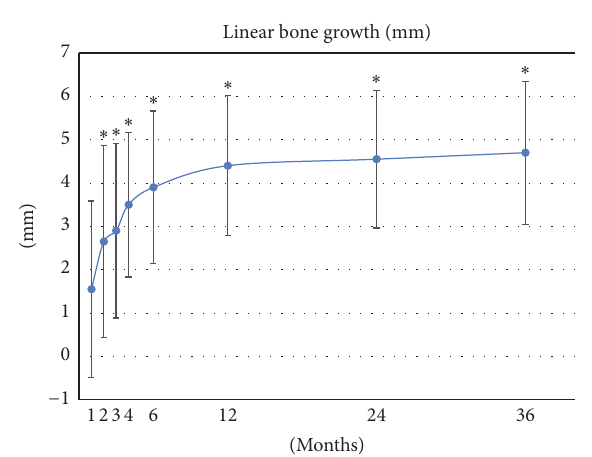
Figure 3: Mean change in the depth of the intrabony defect after operation. Linear bone growth (LBG) significantly increased during the follow-up period. ∗ 𝑝 < 0.01